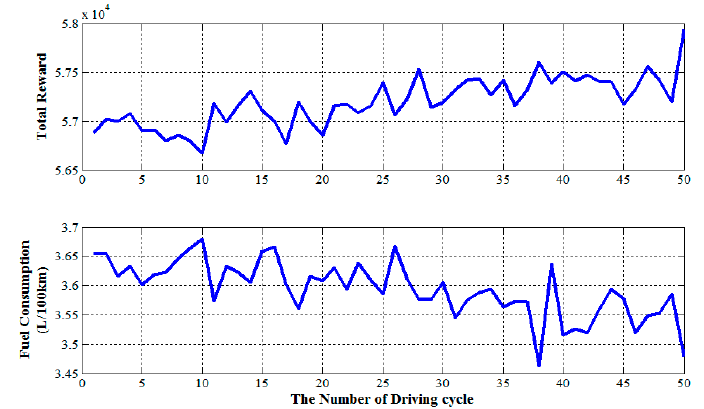
Figure 9. Track of the total reward and fuel consumption in the online application.